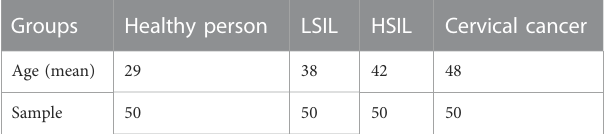
TABLE 1 Basic characteristics of the subjects to be included.